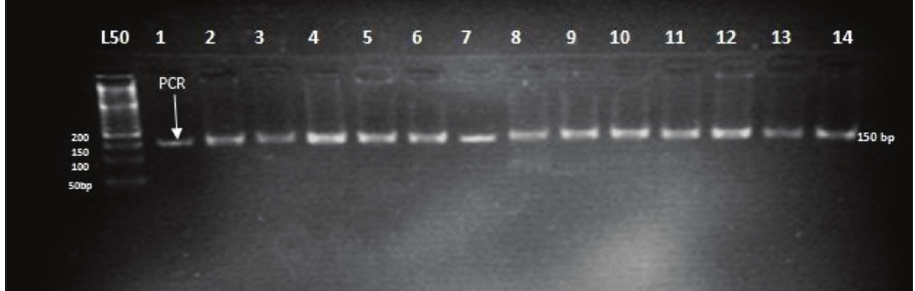
Figure-5: Agarose gel electrophoresis (4%) displaying Xba I digest in an amplified product of Watish BMP15 - FecXI gene in exon 2. Lane 1: PCR product. Lanes 2-14: Represent ++ 150 bp. Lane L: 50 bp DNA Ladder.